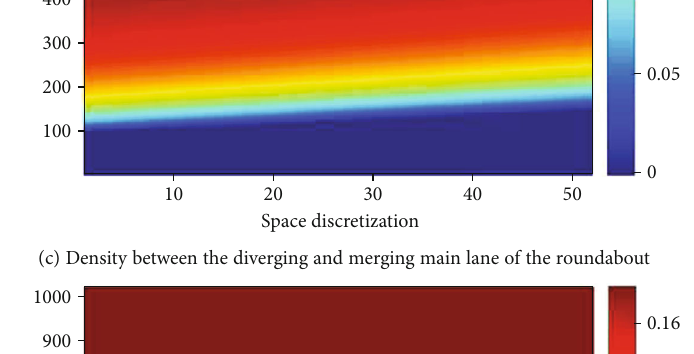
, S , and S as shown in (c) with corresponding fl uxes displayed in (b) and (d), 2 4 6